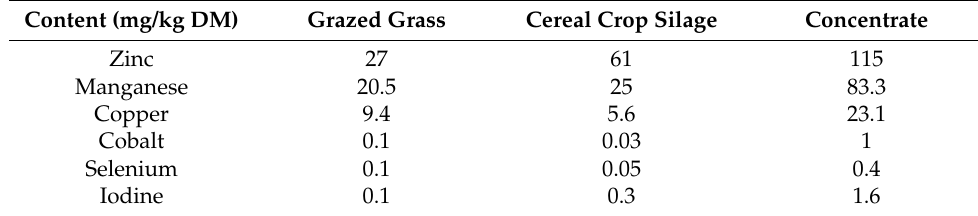
Table 4. Mineral content of the different feedstuffs from cows’ diet.